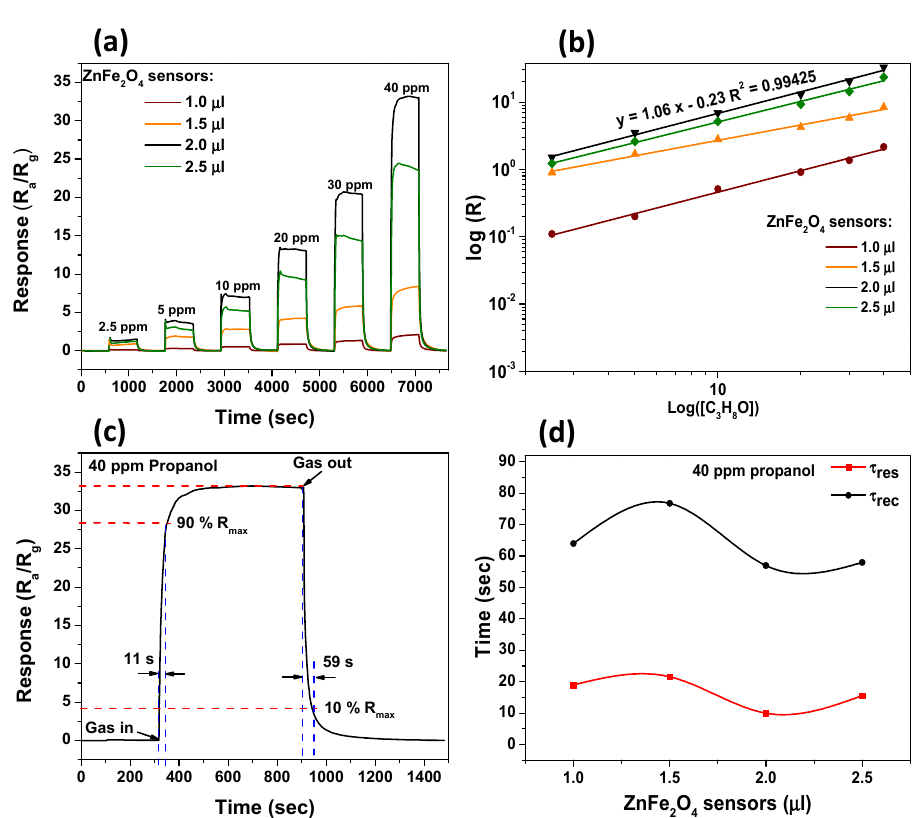
Figure 7. ( a ) Transient response curves, ( b ) log response against log concentration, ( c , d ) measurements and response-recovery times plot of the active ZnFe 2 O 4 NP sensing layers produced at volumes of 1.0, 1.5, 2.0, 2.5 µL towards 40 ppm at an operating temperature of 120 °C.